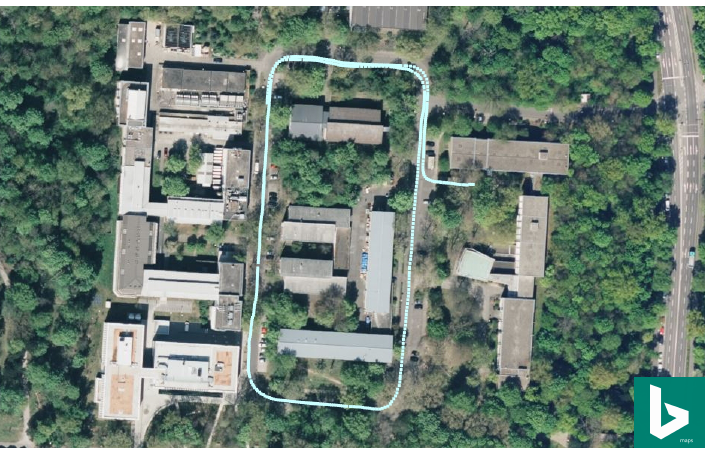
Figure 2. The vehicle driving track used for evaluation shown in Bing aerial imagery using the GNSS measurements for